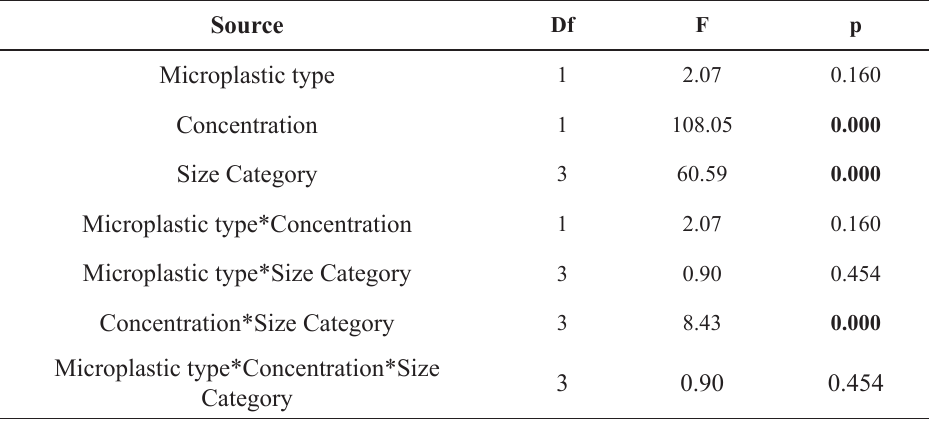
Table 1: Statistical information following General Linear Model (GLM) of Arbuscular Mycorrhizal Fungi (AMF) spore count against microplastic type (MFB and MFL), concentrations (0.0 and 8.4%), size categories (45, 63, 125, and 500 µm) and their interactions. Boldface indicates statistical